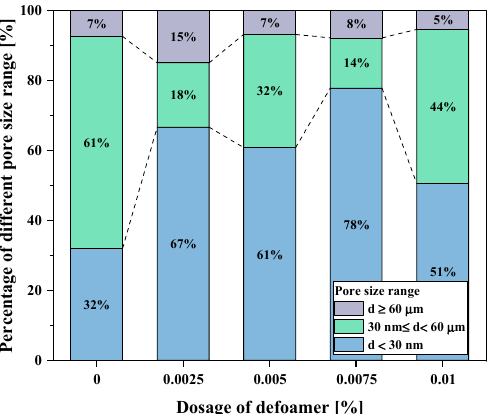
Figure 5. Influence of defoamer on the percentage of different pore size ranges in the grouts.